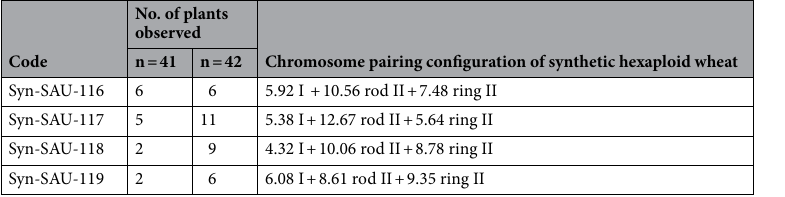
Table 7. Chromosome observation of synthetic hexalpoid